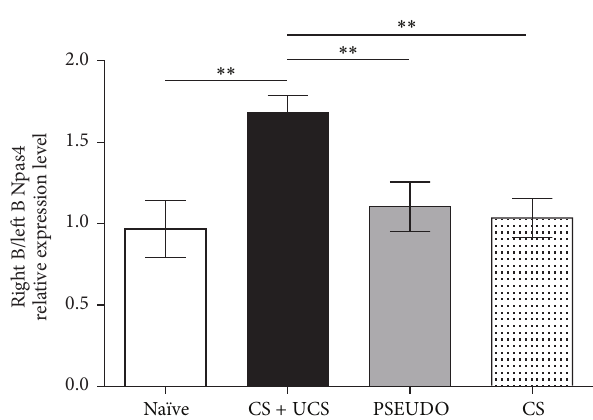
Figure 4: Changes in Npas4 expression induced by training. In trained (CS + UCS) animals expression of Npas4 in the right (trained) row B of barrels is elevated in comparison with left (control, unstimulated) row B. Sole stimulation of whiskers (CS only) and application of unpaired CS and UCS (PSEUDO) do not produce increase in Npas4 expression in comparison with control side. Data are presented as ratio of Npas4 expression level in right and left row B of barrels; mean ± SEM ∗∗ 𝑃 < 0.01 .